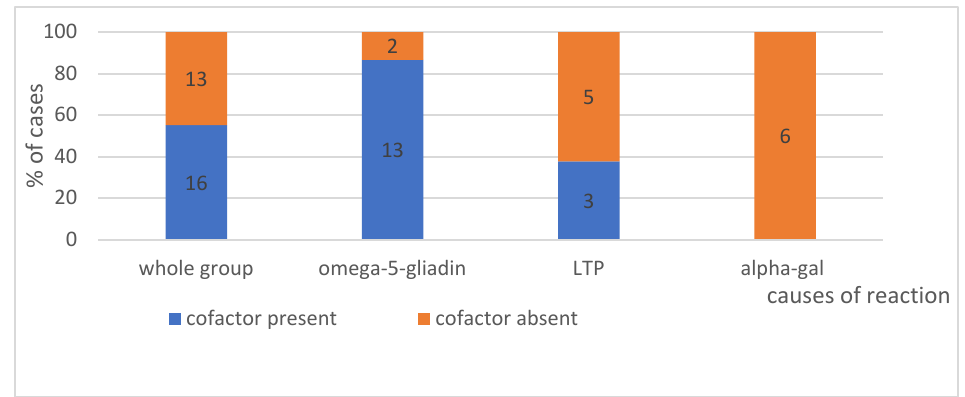
Figure 4. The presence of a cofactor in analysed group, with division into individual causes. Absolute values, no of patient-are given in the diagram.